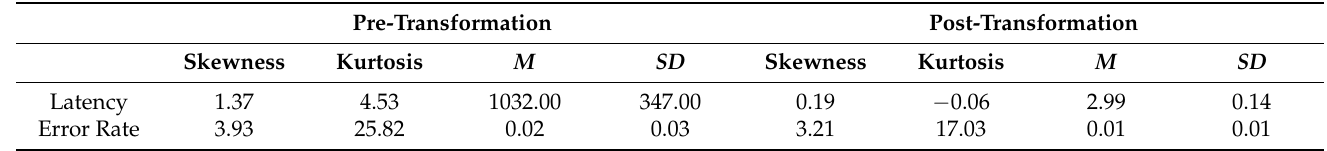
Table 2. Pre- and Post-Transformation Normality for Scores on Latency Values and Error Rates on the DSST.